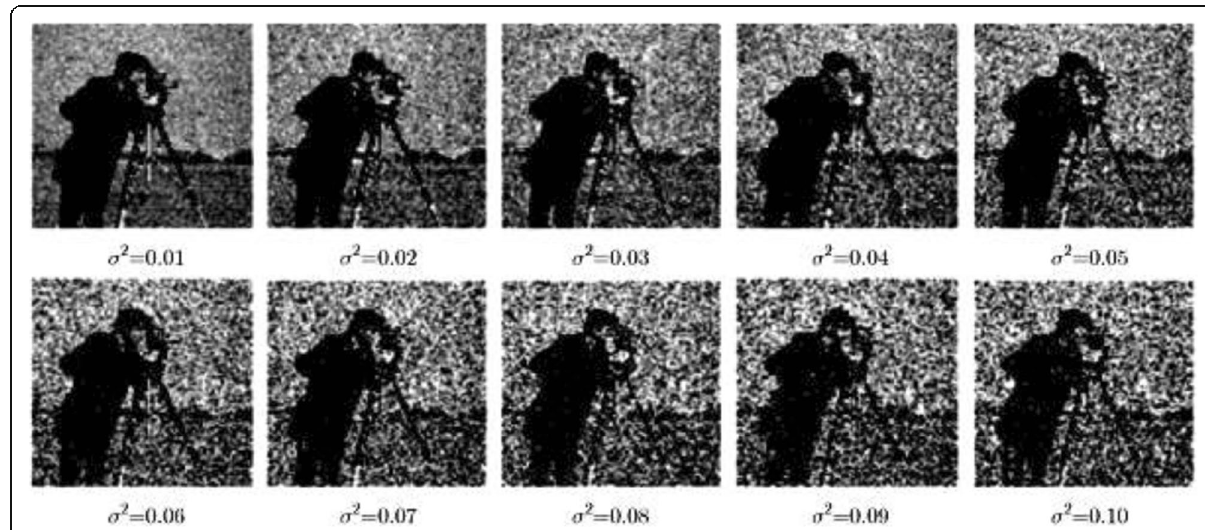
Fig. 8 Cameraman image that contains Gaussian noise with different